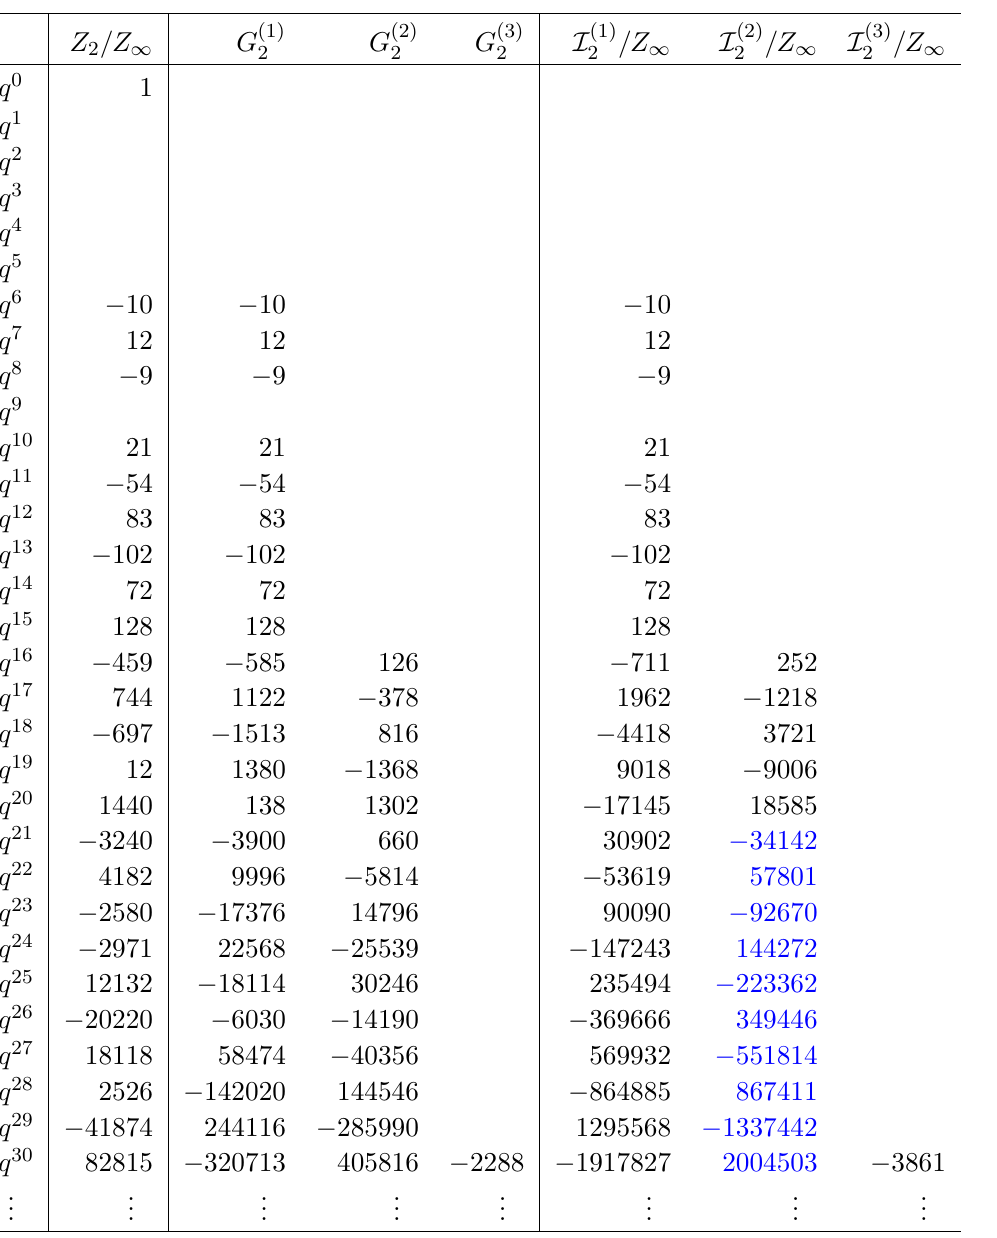
Table 2 . Comparison of the 1 / 16 BPS index for N = 2 with the giant graviton expansion, (2.33), of [10] for G ( m ) and the wrapped D3-brane expansion of [8] for I ( m ) N